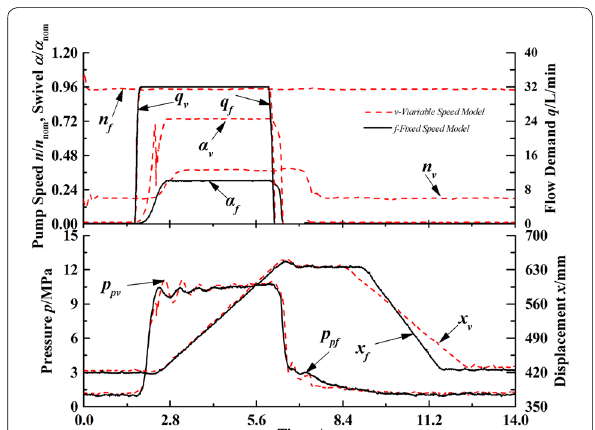
Figure 15 Actual speed and swivel of the pump